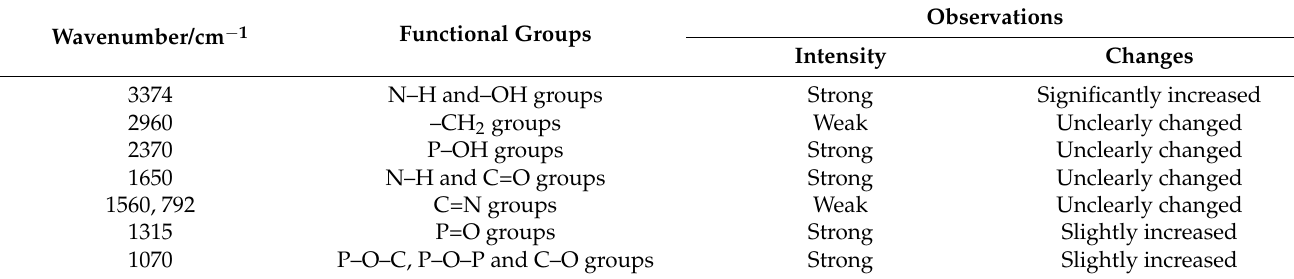
Figure 11. Fire-resistant time of the transparent coatings at different accelerated ageing cycles. Table 6. The FTIR functional groups of the MPPBs coatings after accelerated ageing